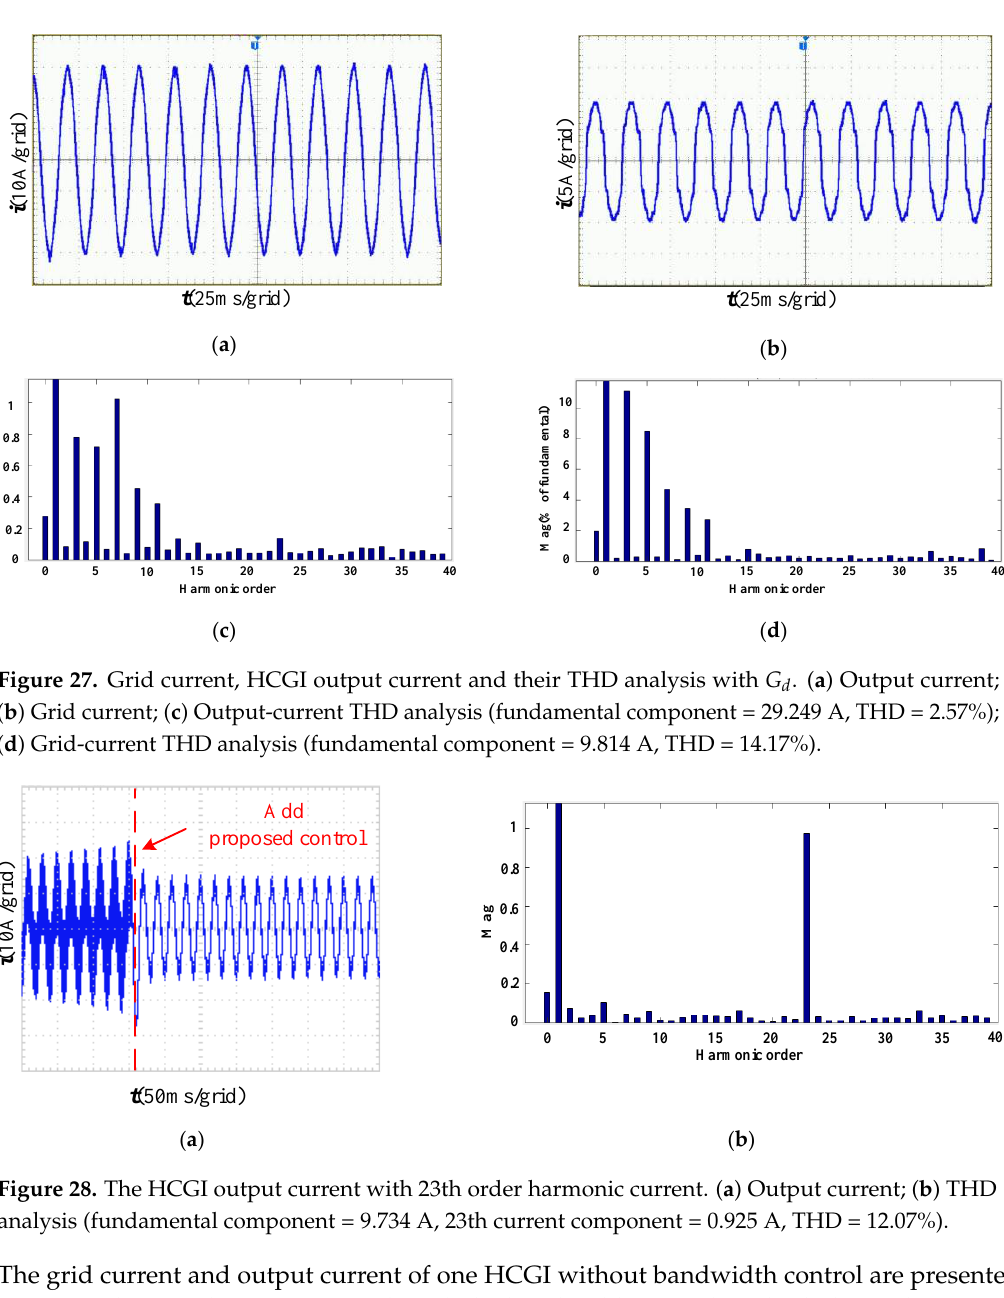
Figure 28. The HCGI output current with 23th order harmonic current. ( a ) Output current; ( b ) THD analysis (fundamental component =9.734 A, 23th current component = 0.925 A, THD = 12.07%).